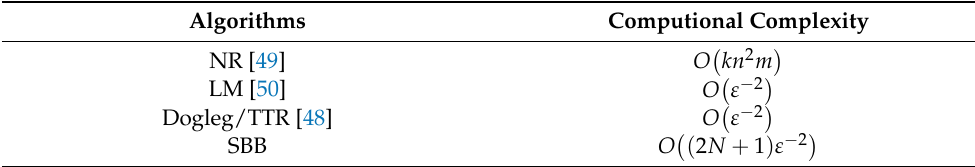
Table 1. Algorithms Computational Complexity